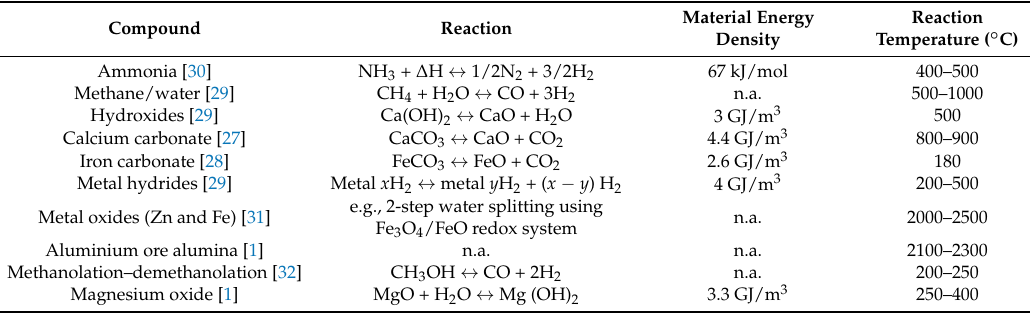
Table 3. Typical chemical storage materials and reactions. Reprinted with permission